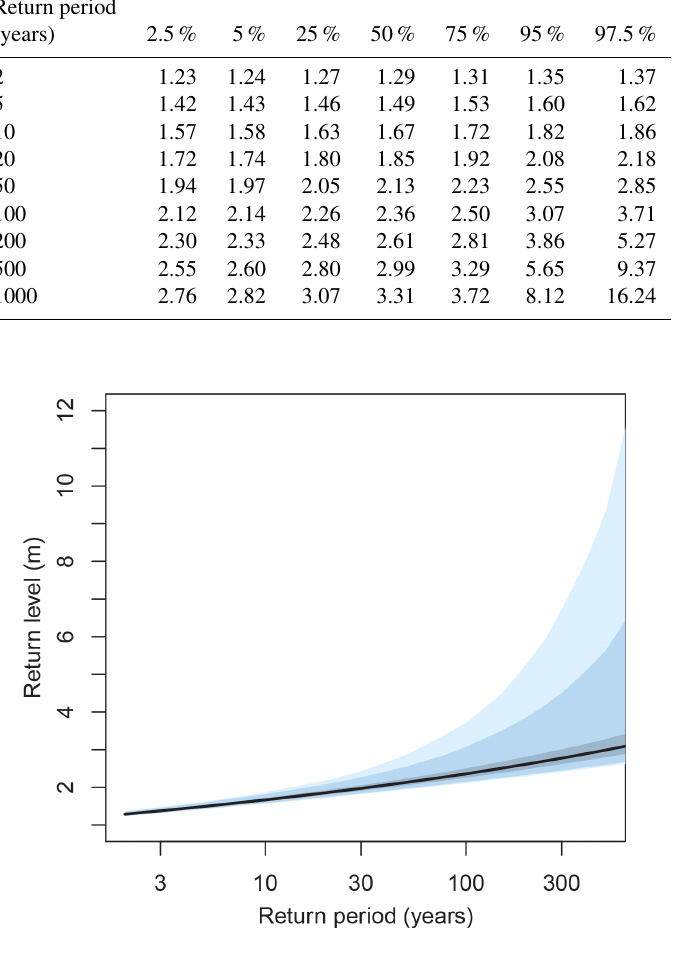
Figure A1. Storm surge return periods (years) and associated return levels (meters) in 2065 for Norfolk, using the full nonstationary multi- covariate BMA model. The solid line indicates the ensemble median, the darkest shaded region denotes the 25th–75th percentile range, the medium shaded region denotes the 5th–95th percentile range and the lightest shaded region denotes the 2.5th–97.5th percentile